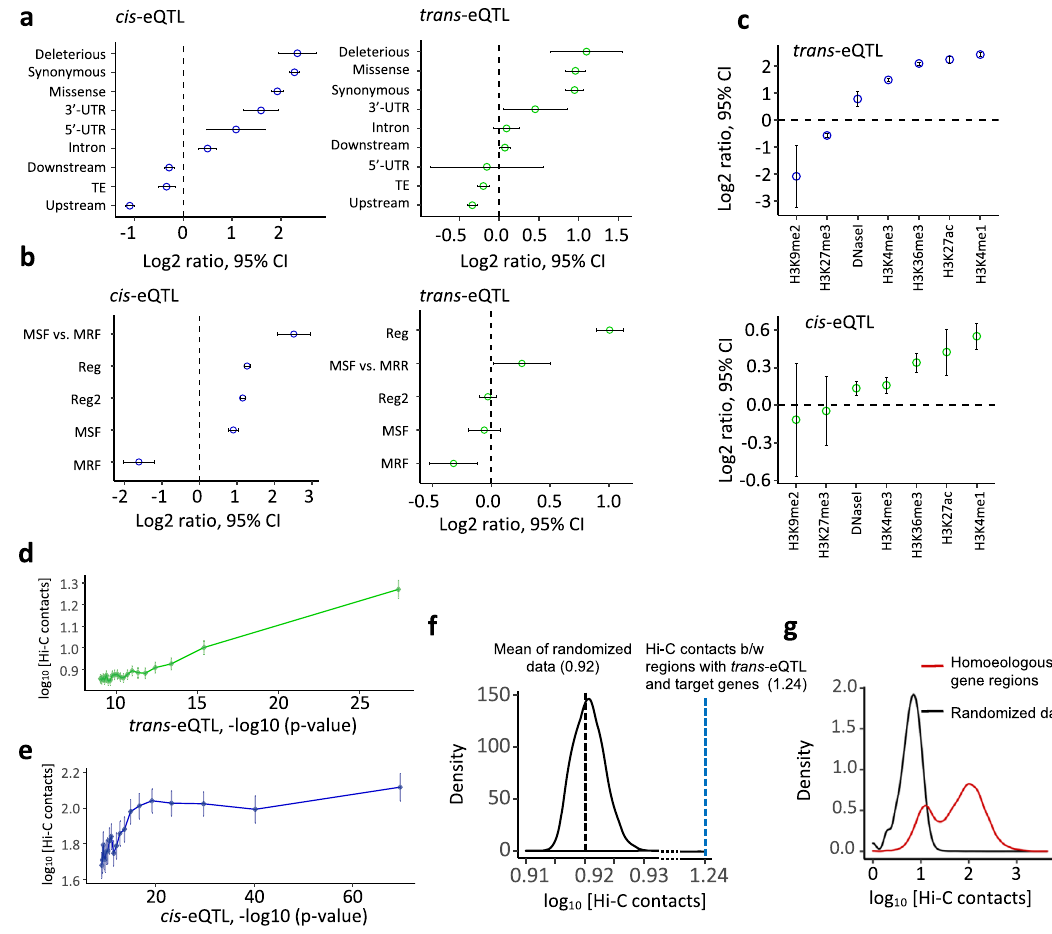
Fig. 3 Functional annotation of eQTL. The x -axis represents eQTL enrichment expressed as the log 2 of the proportion of eQTL within speci fi c classes of SNP variants ( y -axis) relative to the proportion of eQTL within the random samples of SNPs. All analyses of enrichment and Hi-C contacts are based on 2,021,936 SNPs, 14,645 trans -eQTL and 8568 cis -eQTL. a Mean enrichment of cis -eQTL and trans -eQTL among SNP variants from different functional classes de fi ned based on gene and transposable element (TE) annotation ( N = 2,021,936 SNP sites). b Mean enrichment of cis -eQTL and trans -eQTL in the MNase Sensitive Footprints (MSF), MNase Resistant Footprints (MRF), and regulatory regions identi fi ed based on the sensitivity to DNase I treatment, epigenetic variation, and open chromatin marks. Enrichment was assessed relative to genome-wide patterns, except for MSF vs MRF, where enrichment was tested for eQTL located within MSF relative to MRF. ‘ Reg ’ region corresponds to regulatory elements, as de fi ned in Li et al. 27 . ‘ Reg2 ’ corresponds to regions classi fi ed as states 5 – 7 in the same study. c Mean enrichment of cis -eQTL and trans -eQTL in the epigenetically marked regions. d Relationship between the binned trans -eQTL p -values and frequency of Hi-C contacts between regions harboring a trans -eQTL and its target gene. Data are presented as mean values ± SEM. e Relationship between the binned distal (>2 Mbp) cis -eQTL-target gene p -values and frequency of Hi-C contacts between regions harboring a cis -eQTL and its target gene. Data are presented as mean values± SEM. f Comparison of Hi-C contacts (log10-transformed) between regions harboring trans -eQTL-target gene pairs to Hi-C contacts between a random set of genes (two-sided Wilcoxon rank-sum test, W = 191,789,322, p - value = 8.8e − 16). g Comparison of Hi-C contacts (log10-transformed) between the pairs of homoeologs and random pairs of